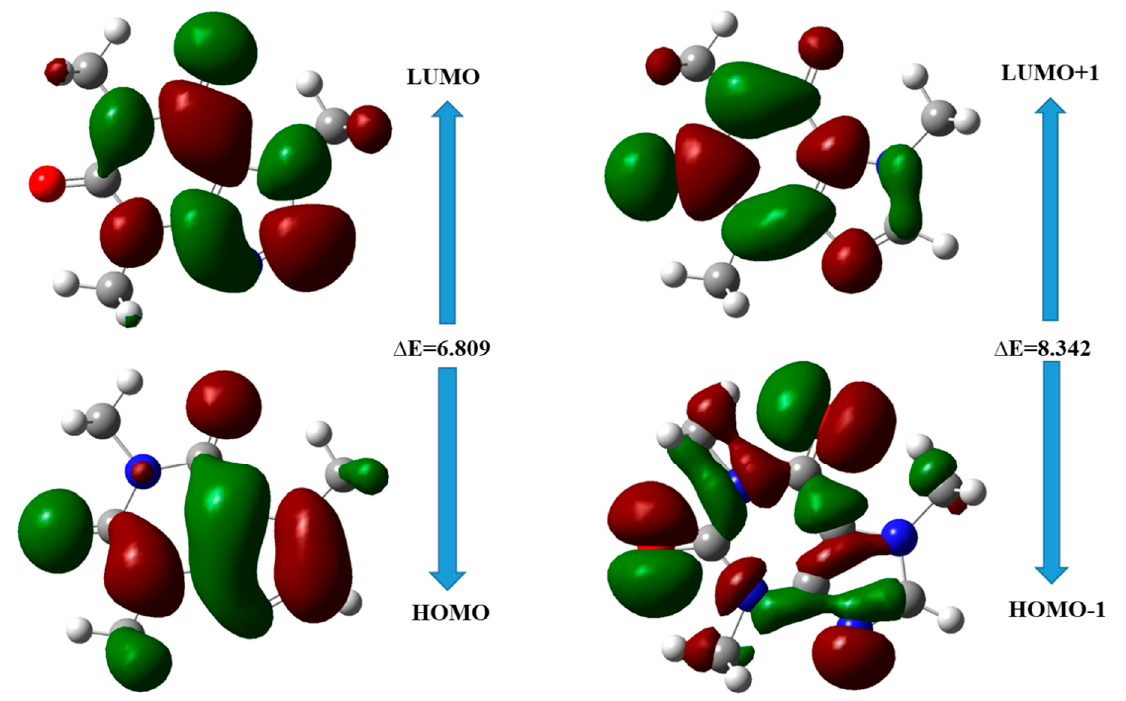
Figure 9. Frontier molecular orbitals of compound 2.